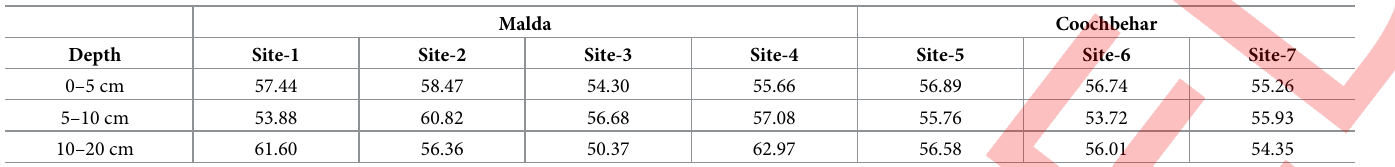
Table 7. LP 2/(LP1 + LP2) ratio in 0–20 cm soils of seven sites of Coochbehar and